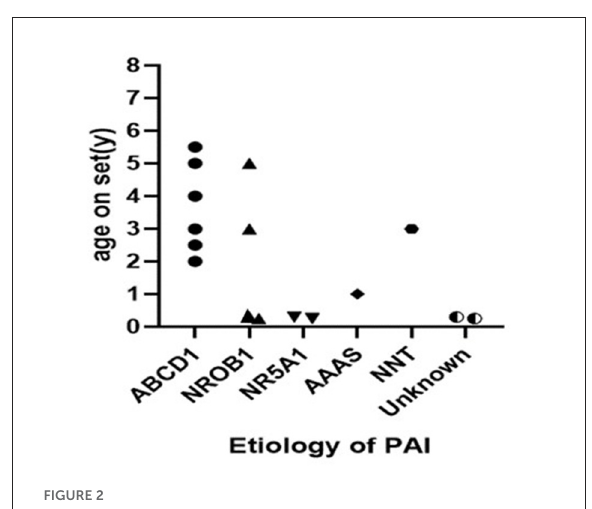
FIGURE2 The age onset of patients with PAI.